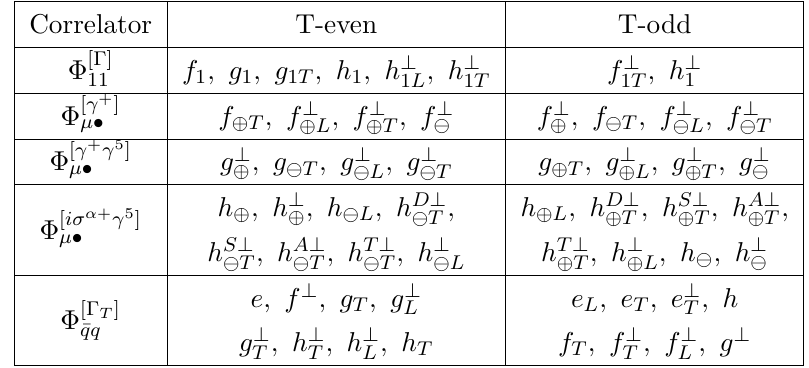
Table 2 . The T-parity of TMD distributions of the twist-two, twist-three and bi-quark distribu-